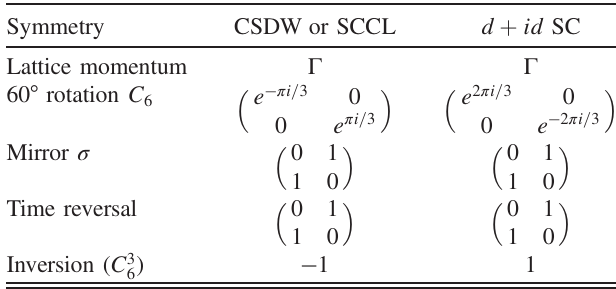
TABLE I. Twofold symmetry irreps of the many-body ground- state wave functions on 4 N × 4 N × 2 lattices in the 60°-rotation eigenbasis. (See Fig. 1 for definitions of the symmetry